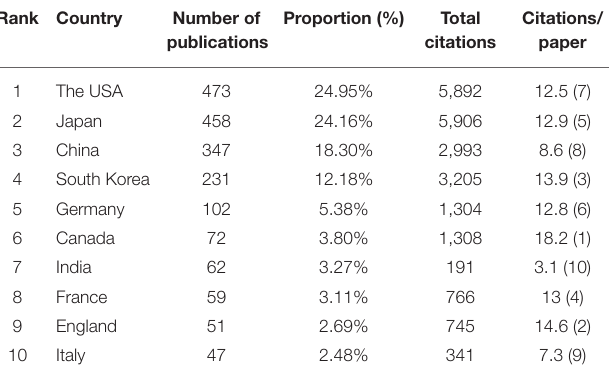
TABLE 1 | The top 10 countries according to total publications during 2010–2019.